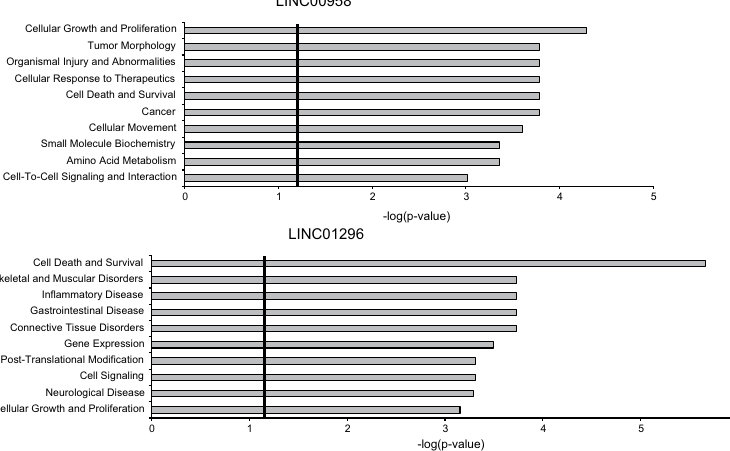
Figure 4. Ingenuity Pathway Analysis. The most significantly biological functions and diseases associated with altered intracellular levels of LINC00958 or LINC01296 in FL3 cells 24 h post transfection are shown. Only RNAs demonstrating log2 ratios <− 0.6 or > 0.6, when comparing cells transfected with LNA TM GapmeR (Scr) to cells transfected with LNA TM GapmeRs targeting either LINC00958 or LINC01296 (LNA-1 and LNA-2), were included in the analysis (LINC00958: n = 1933 genes and LINC01296: n = 915 genes). Threshold value; p = 0.05. The analyses were based on knowledge from all species, all tissues, and all data sources.